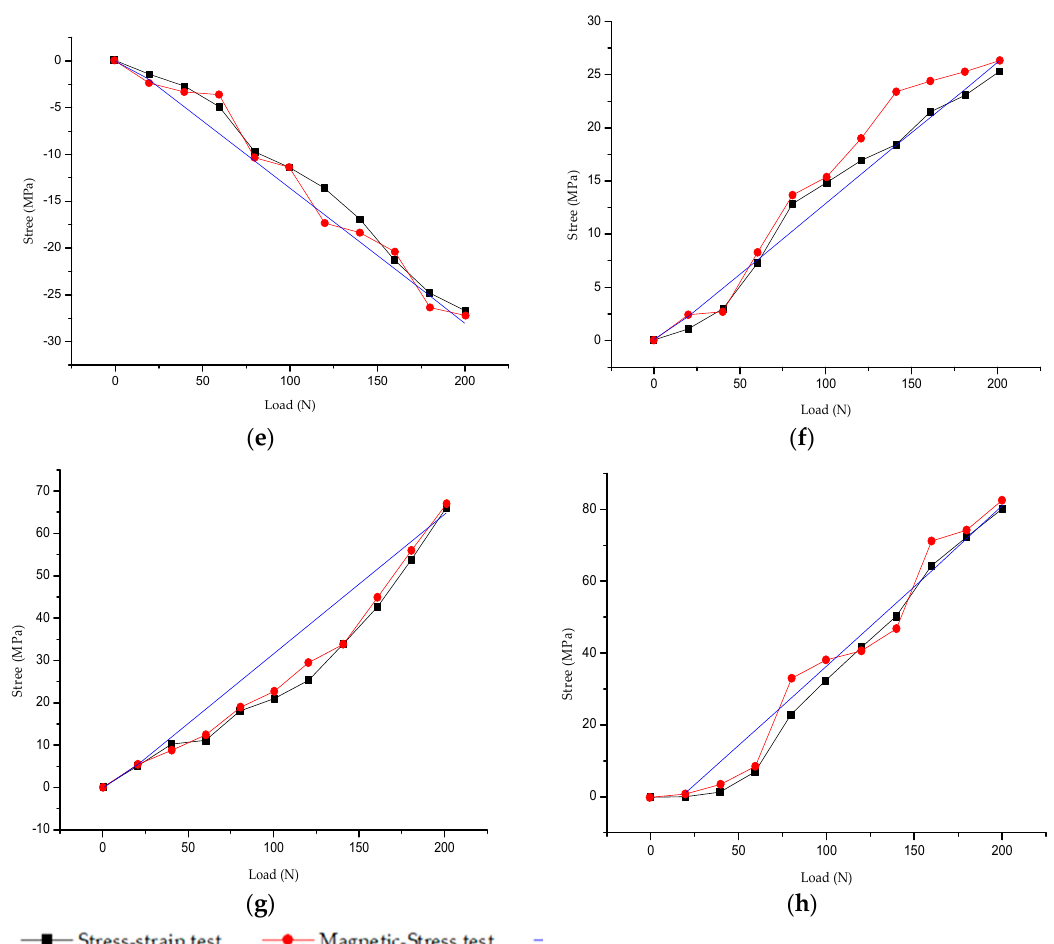
Figure 12. Comparisons of numerical calculations and tests: ( a ) 1–2 rod, ( b ) 1–7 rod, ( c ) 3–4 rod, ( d ) 3–9, ( e ) 4–10 rod, ( f ) 6–7 rod, (g) 8–9 rod, ( h ) 10–11 rod.